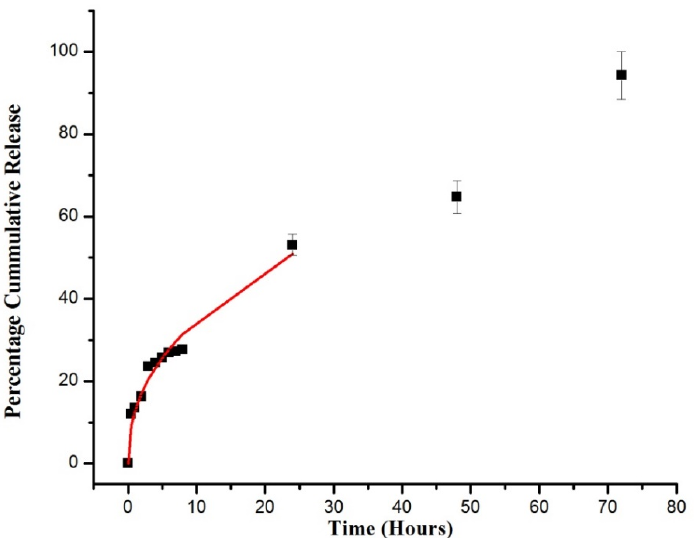
Figure 9. In vitro DSP dissolution from hydrogels (AP-8). Release curve shows the Korsmeyer-Peppas model on the first 60% release (shown by the red line).